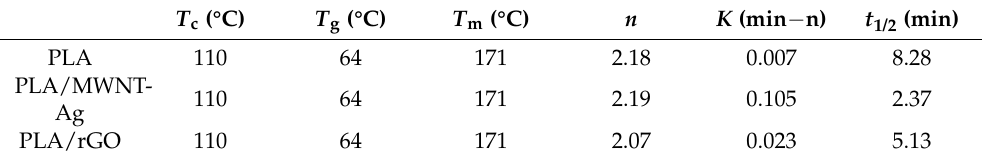
Table 3. Thermal characteristic parameters of PLA-based films, obtained from